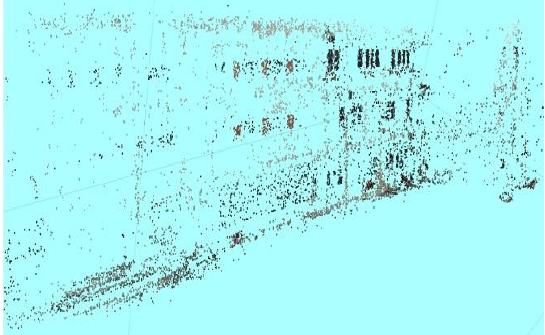
Figure 6: Sparse point cloud model